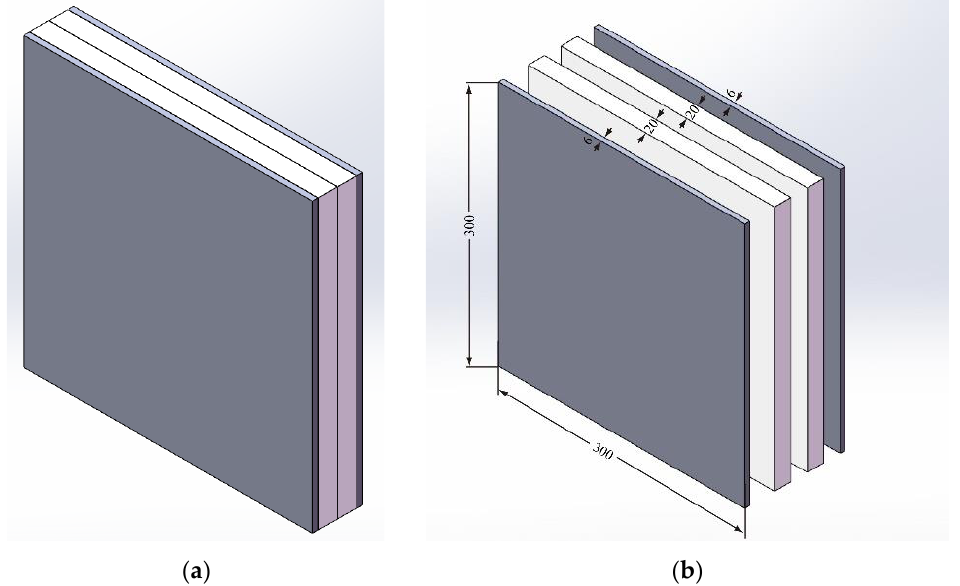
Figure 1. Structures of UHMWPE composite armor. ( a ) Assembly drawing. ( b ) Component drawing.